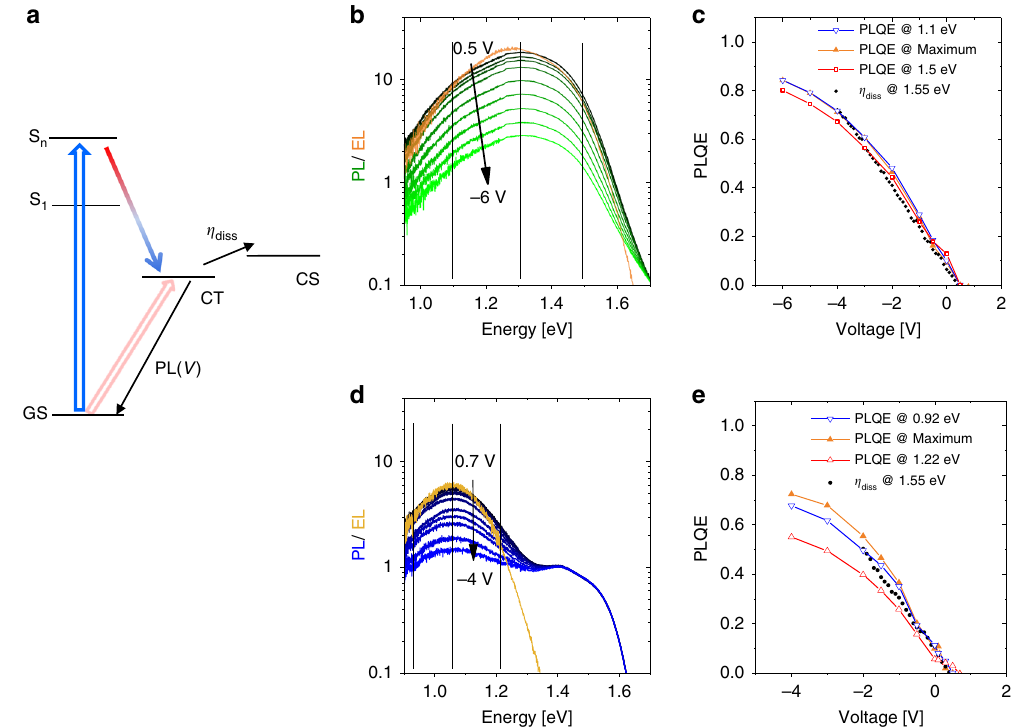
Fig. 5 Bias-dependent photoluminescence; a energy scheme describing the competition between the recombination of the occupied CT state manifold, yielding PL with an intensity PL( V ) and the dissociation of the very same manifold into free carrier with an ef fi ciency η (green lines), compared to the EL driven at a bias of 1.2V (orange line), c bias-dependent photoluminescence quenching ef fi ciency PLQE( V ), referenced to a voltage V 0 = 0.5V for a 150 nm thick PCPDTBT:ICBA blend. PLQE data are plotted for three different detection energies, below, at and above the PL maximum (line-connected symbols). Solid black points display the prediction by Eq. 1 based on our bias-dependent TDCF experiments on the same devices. d , e the same for a 150 nm thick PCPDTBT:PCBM blend with the EL at 0.7